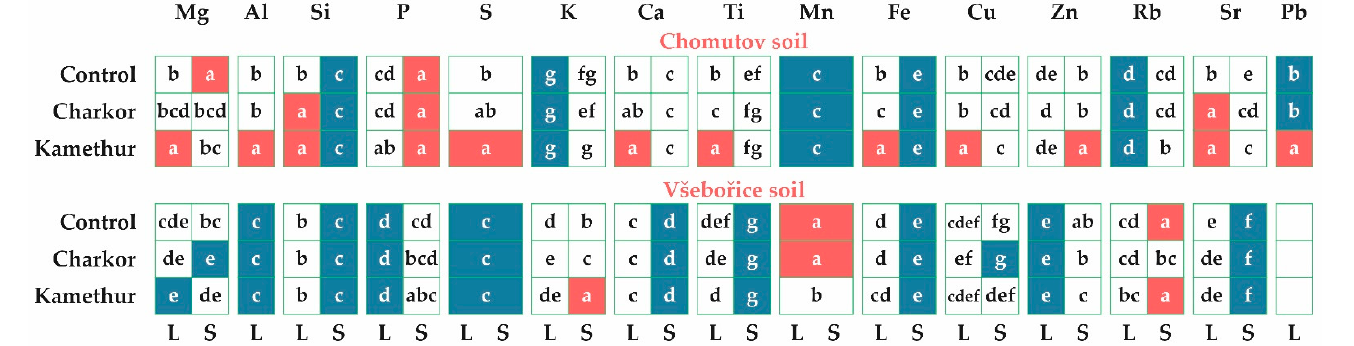
Figure 5. BCFs for M×g, as affected by the PGRs. L–leaves; S–stems. Different letters indicate a significant difference between the values ( p < 0.001).